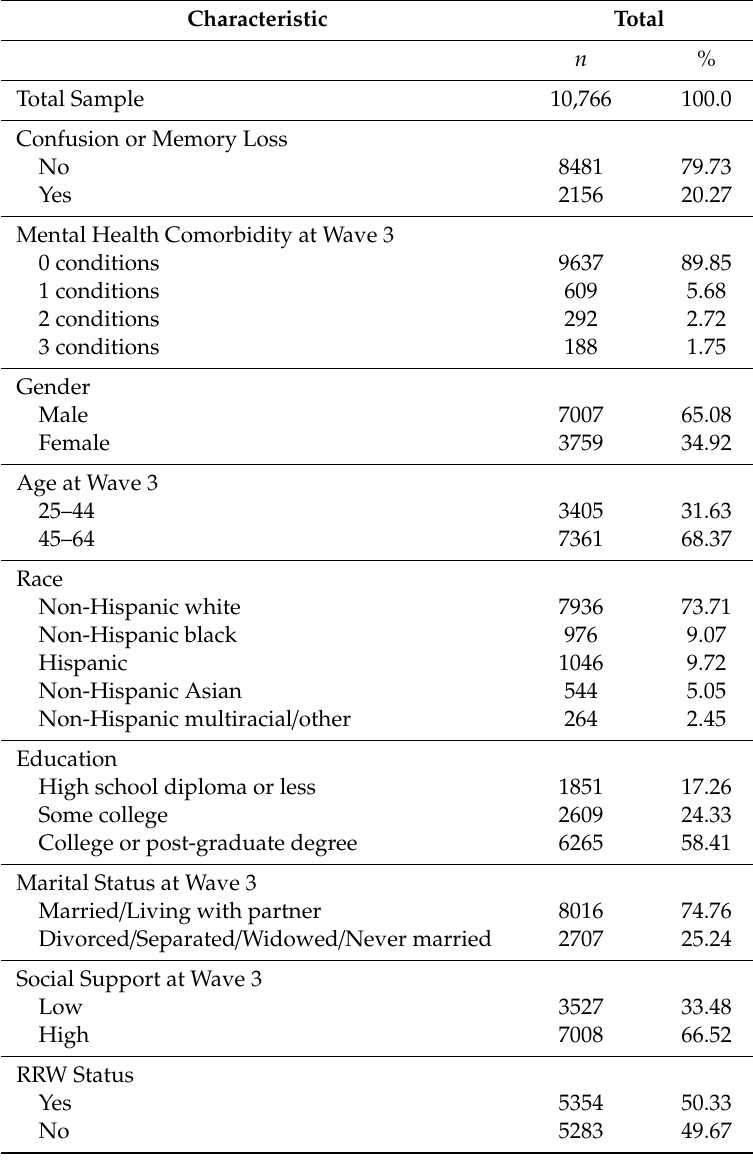
Table 1. Description of study sample, including mental health